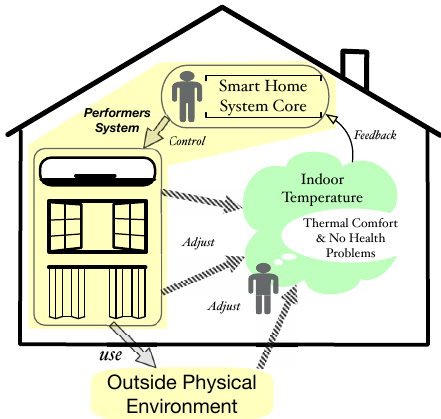
Figure 2. An example of the Performers